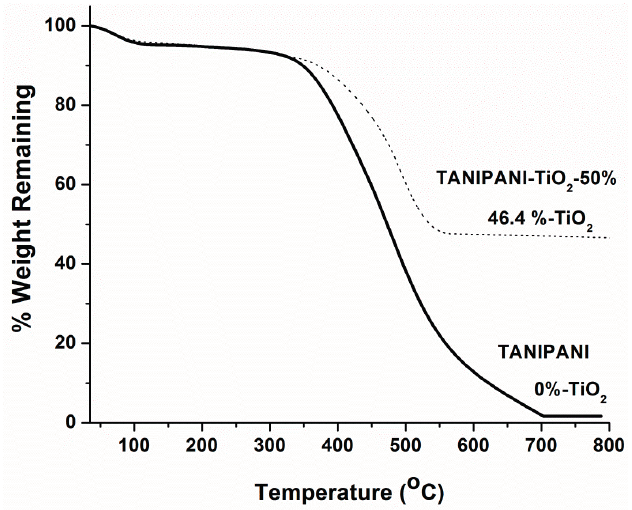
Figure 2. Thermal degradation curves of undoped TANIPANI and TANIPANI-TiO 2 powder